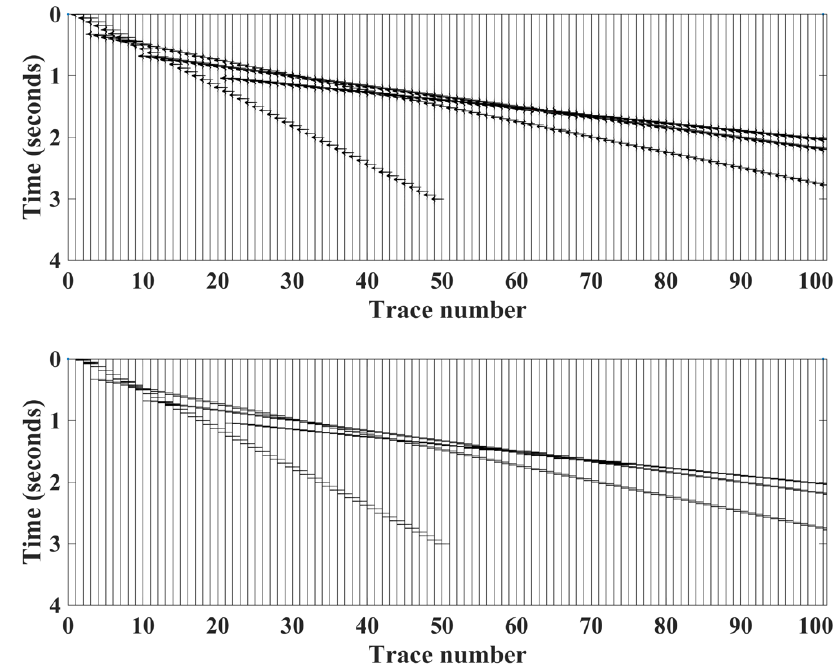
Figure 5. Clean synthetic data ( top ) with the locations of the first and later arrival picks generated using the HEEH method ( bottom ). The direct arrival is indicated by the linear event that has an intercept of zero, while the other linear events indicate head waves from various layer interfaces.